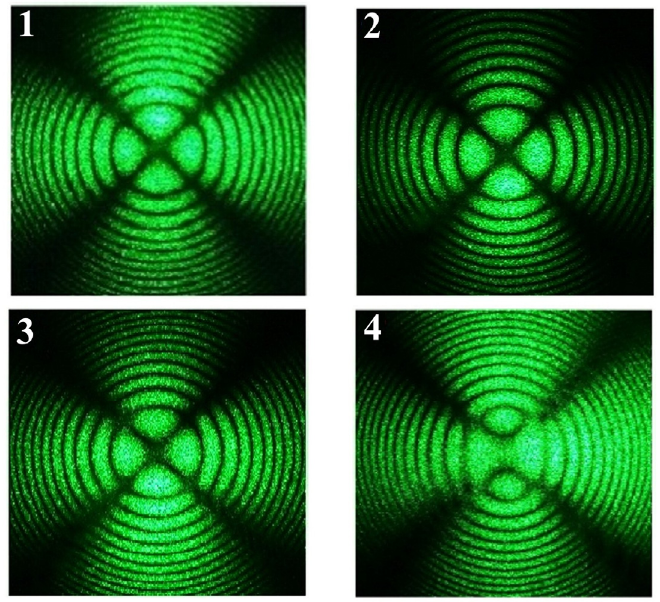
Figure 3. Conoscopic patterns of (1) sample 1, (2) sample 2, (3) CLN, (4) NSLN K 2 O. PILS studies reveal optical damage resistance of the investigated LN